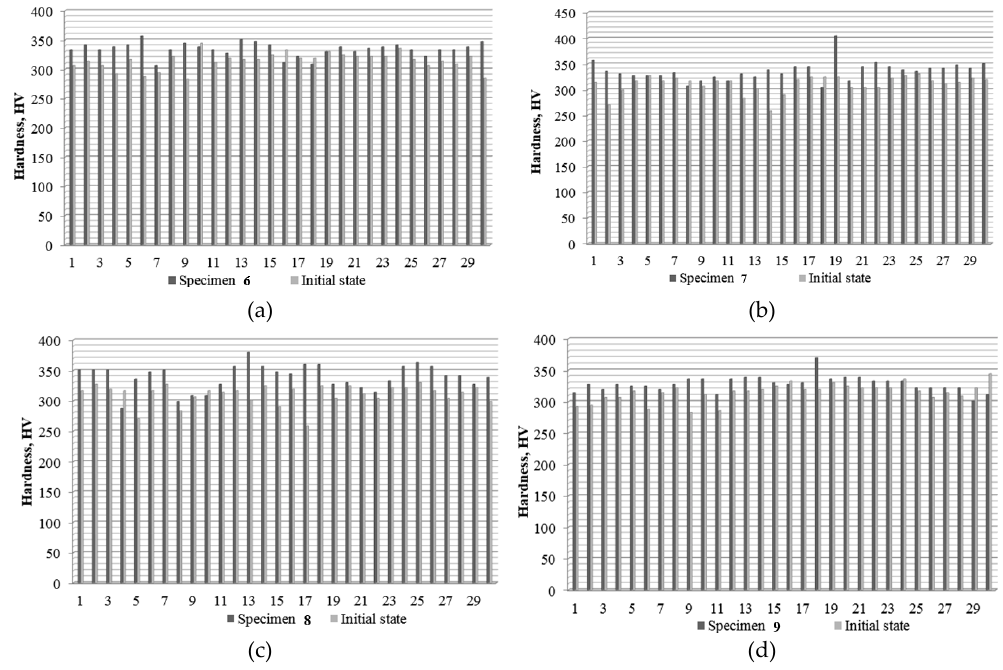
Figure 5. Increase in hardness compared to the initial state of the specimen surface layer of VT23 alloy treated with carbon nanosolutions of different concentration: ( a – c ) by 6.0%, 7.5%, and 8.4%, alloy treated with carbon nanosolutions of di ff erent concentration: ( a – c ) by 6.0%, 7.5%, and 8.4%, respectively; ( d ) polished surface by 4.4%. respectively; ( d ) polished surface by